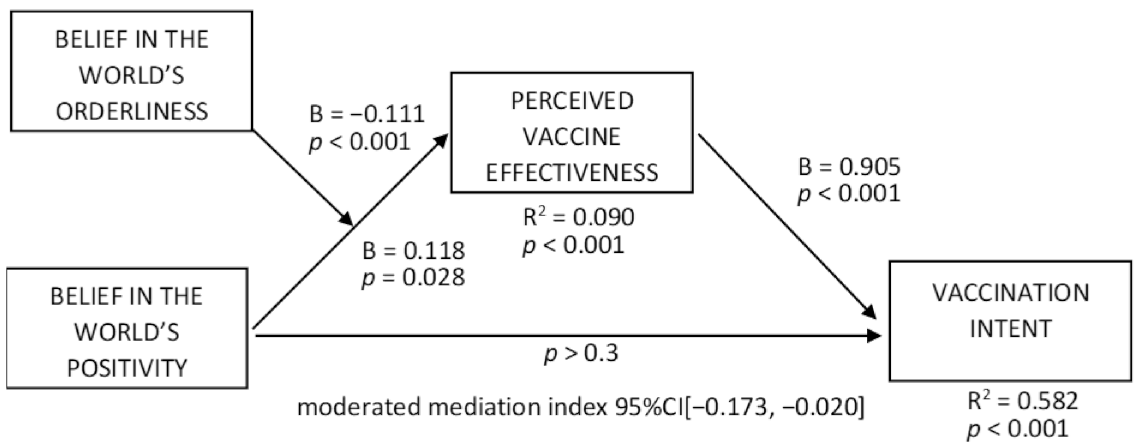
Figure 4. Moderated mediation effects on vaccination